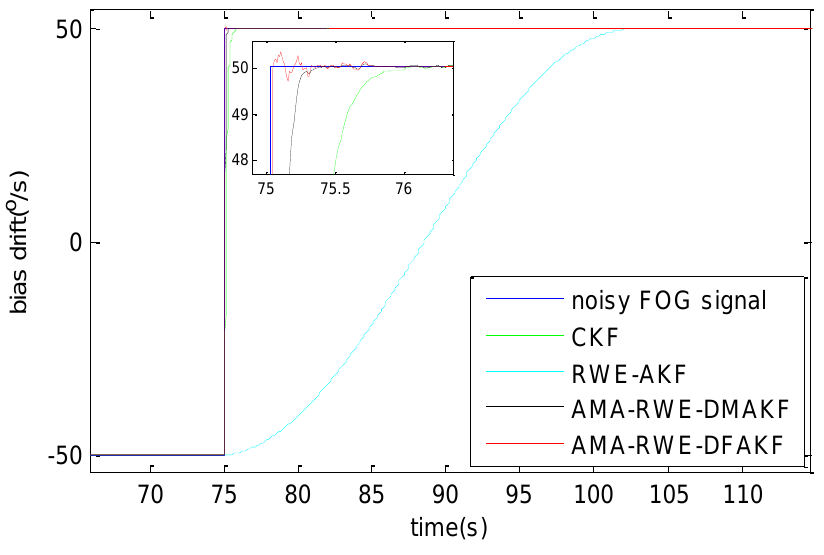
Figure 13. Comparison of denoising results for FOG dynamic